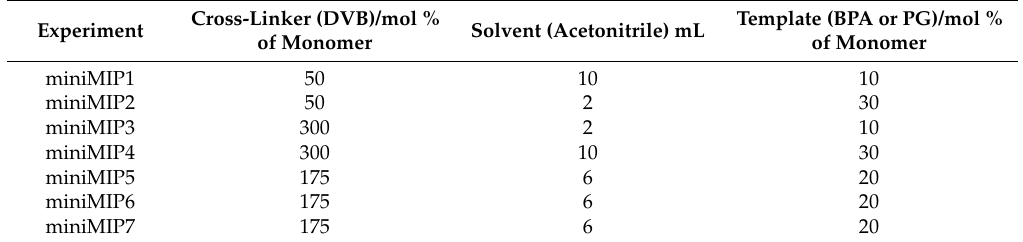
Table 1. Experimental conditions for the synthesis of molecularly imprinted polymers (MIPs) according to the experimental